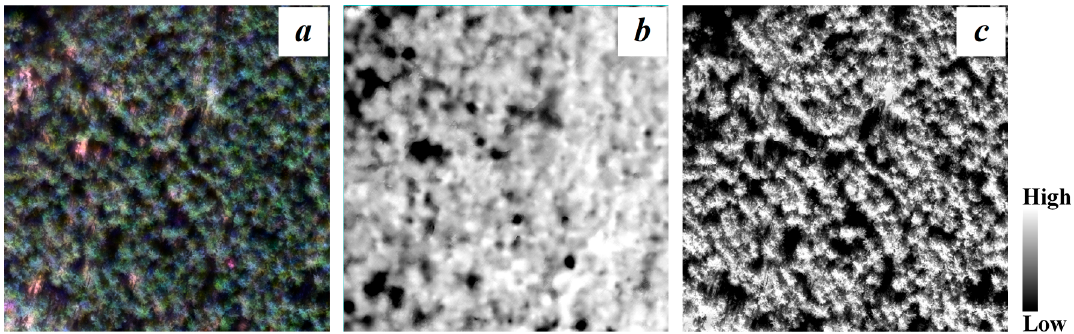
Figure 6. Sub-area of thick Larix canopy ( a ) and its NDVI ( b ) and NDCSI ( c ) results for verification.